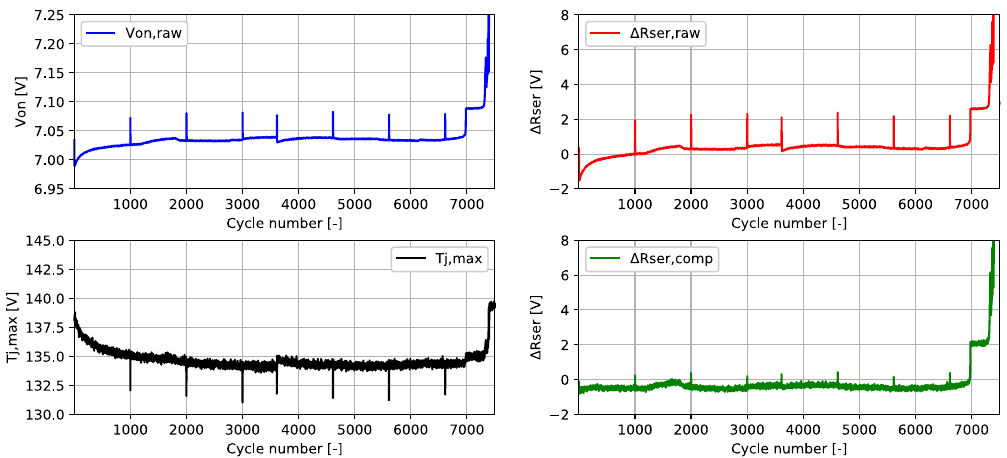
Figure 16. Measured device voltage at heating current (blue, top left), measured maximum junction temperature (black, bottom left), and the calculated serial resistance change without (red, top right) and with junction-temperature compensation (green, bottom right).